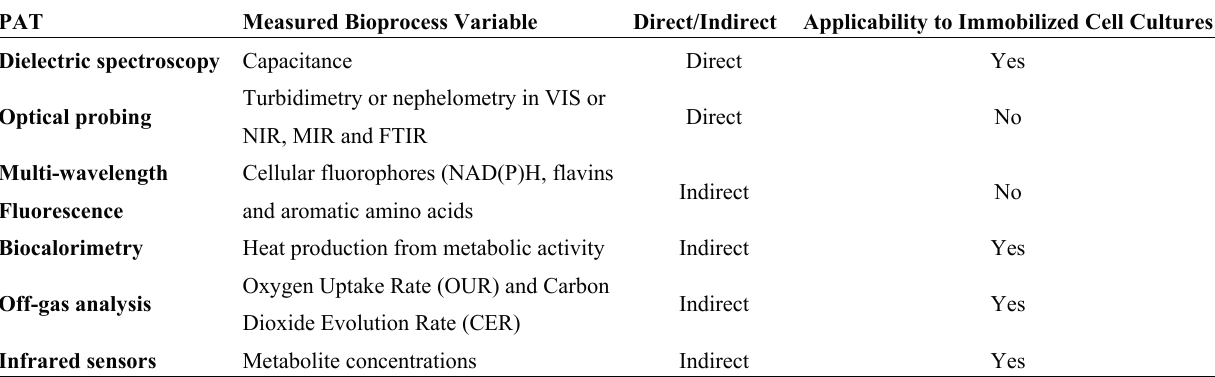
Table 1. On-line direct and indirect methods for biomass estimation and applicability to immobilized cell cultures.